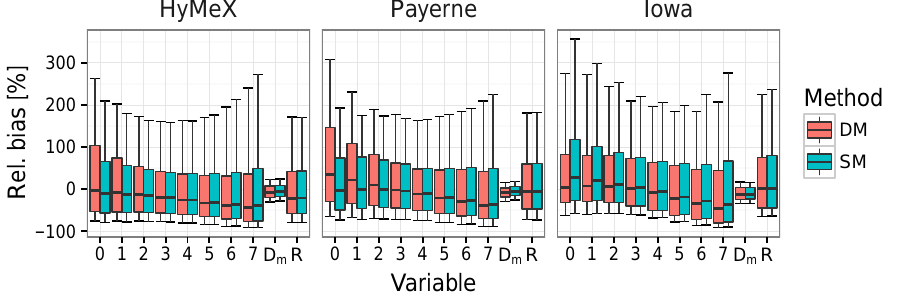
Figure 6. Distributions of relative bias on DSD moments zero to seven, comparing DSDs retrieved using noise-corrected PPI data and those measured by Parsivel networks. Variables and symbols as for Fig.